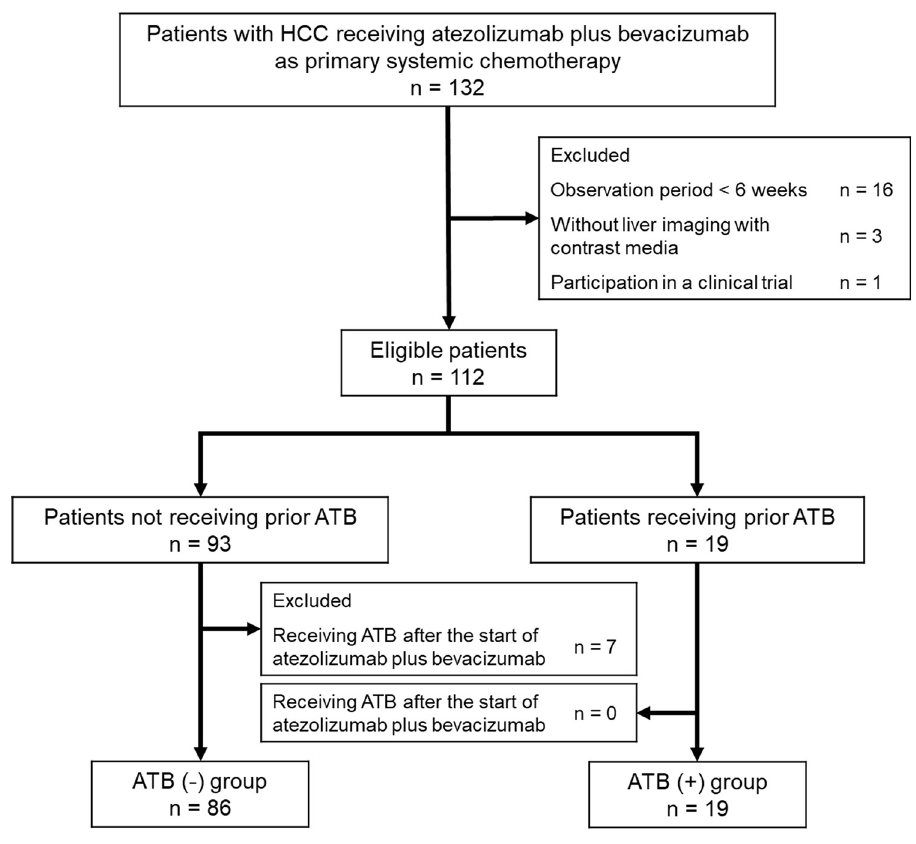
Fig 1. Flowchart of patient selection. Abbreviations: HCC, hepatocellular carcinoma; ATB, antibiotics.